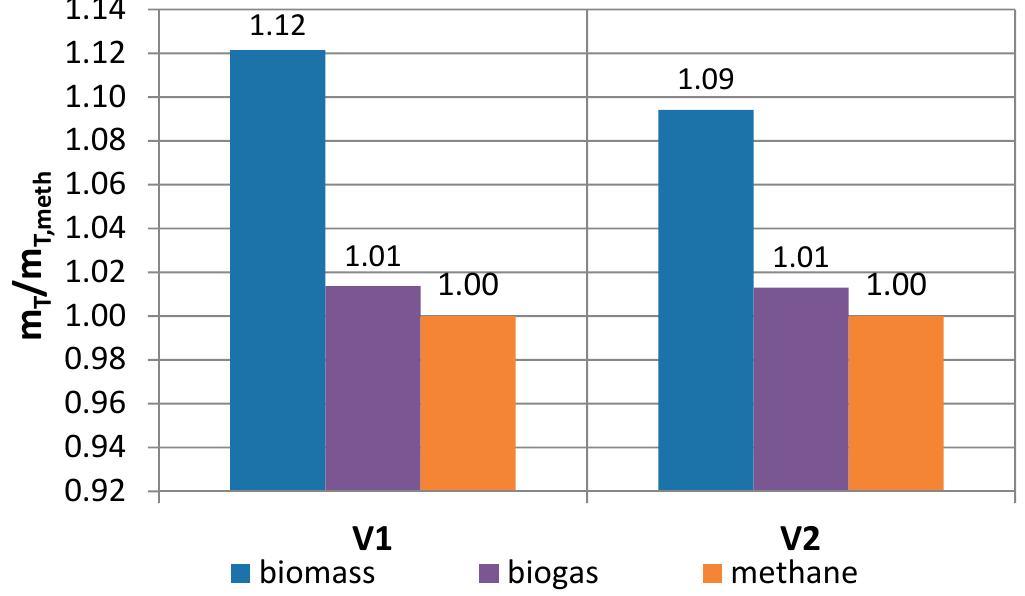
Figure 8. Effect of the structure of the cycle and calorific value of fuel on the exhaust gas mass flow for both variants (related to methane used as a fuel).